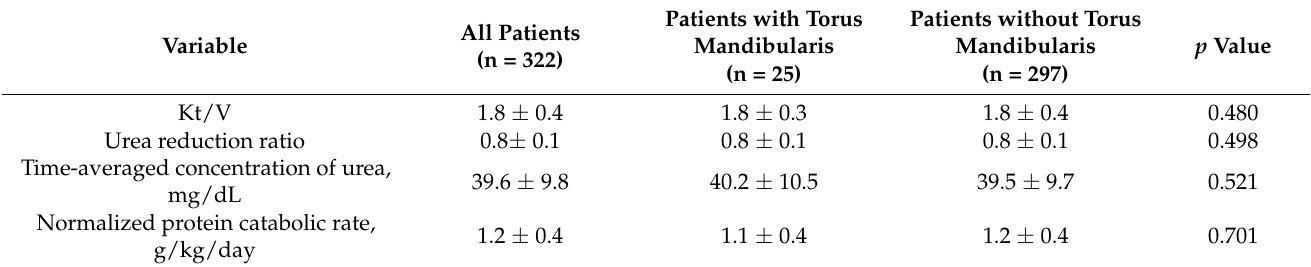
Table 3. Dialysis-related data of hemodialysis patients with and without torus mandibularis (n =